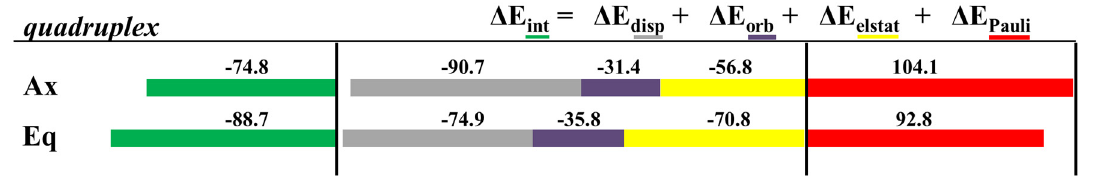
Figure 31. Cumulative bar diagrams for the EDAs associated to the interaction of the most favorable association for each isomer, Ax and Eq, of the [Mo( η 3 -C 3 H 5 )Br(CO) 2 (phen)] metal complex with the considered DNA GQ structure. Energies at B3LYP-D3/TZP level of theory in kcal mol − 1 .